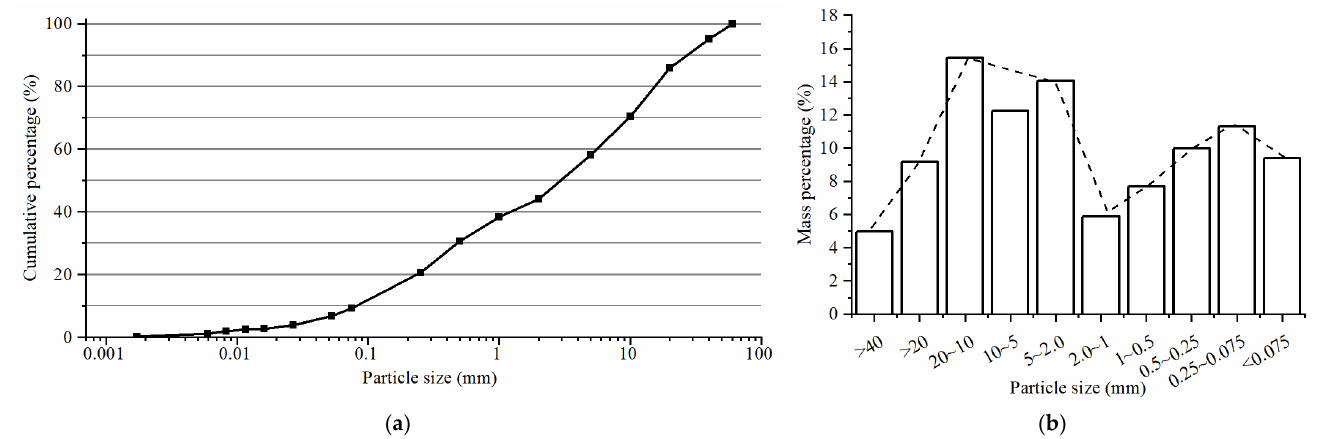
Figure 2. Distribution of particle size of SRM samples. ( a ) Particle-size distribution; ( b ) Histogram.